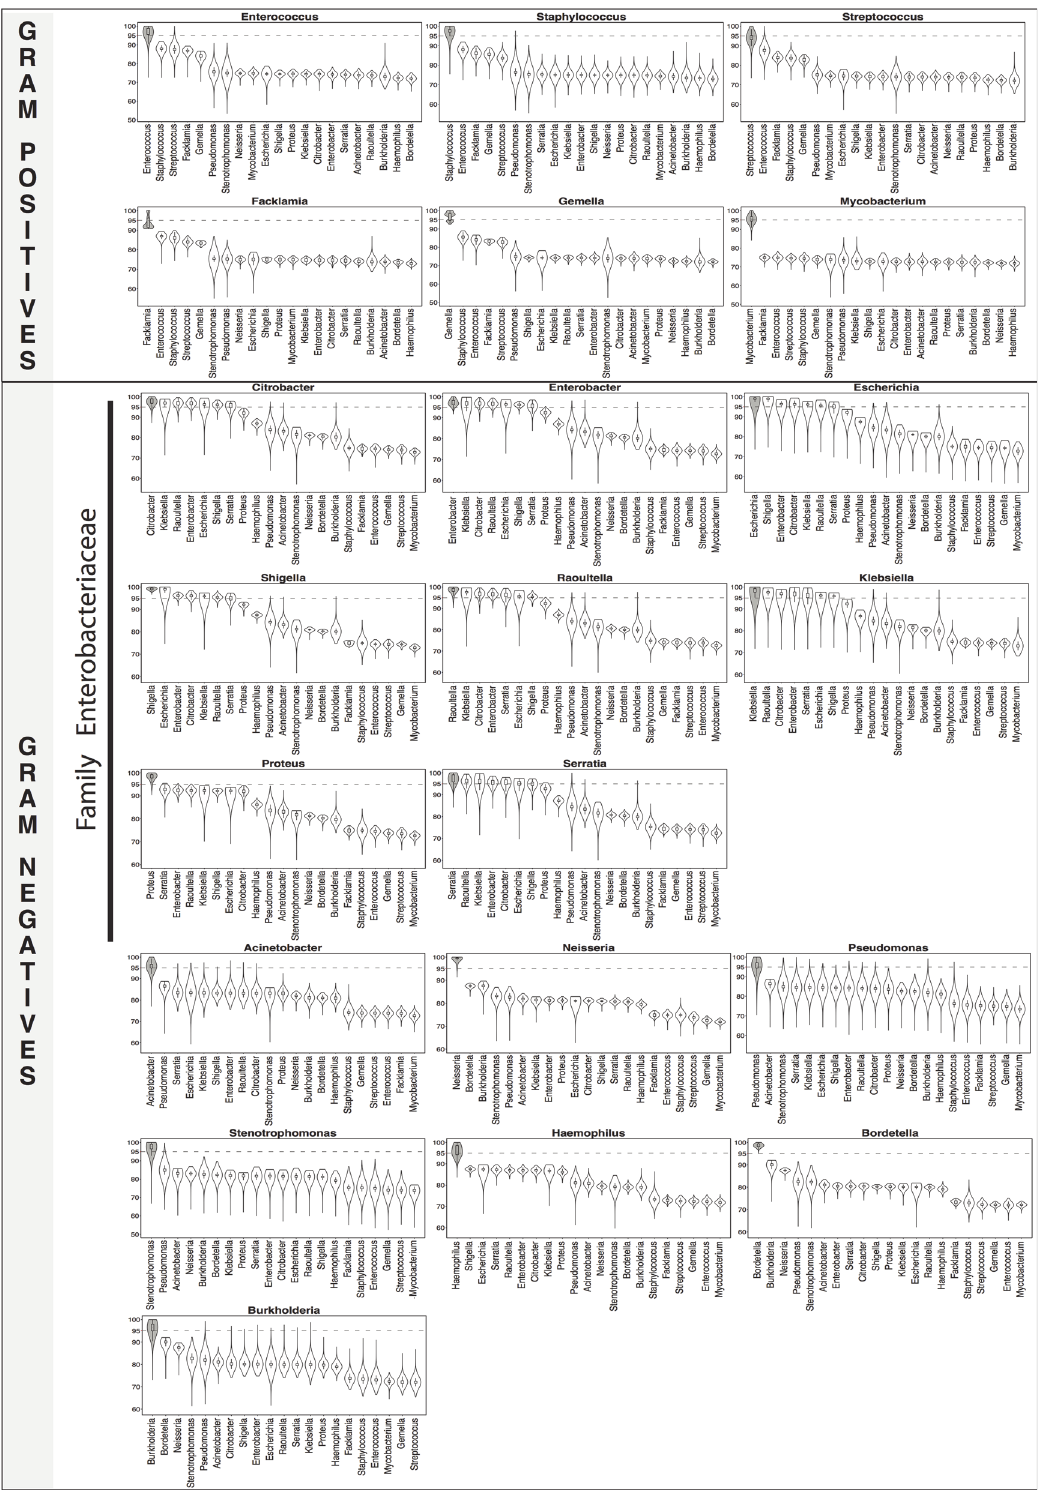
Fig 2. 16S rRNA percent identity within and between genera. Distributions (shown as violin plots) of 16S rRNA percent identity (y-axis of each figure) of pairs of training set sequences belonging to the same (gray) and different genera. 95% identity, the traditional genus level cutoff, has been marked for reference. The genus Mycobacterium has been categorized as a gram-positive in the figure. For all of the genera, sequence variability between sequences from the same genera was significantly higher than between those from different genera for all comparisons (Wilcoxon test one-sided p-value < 0.0001). doi:10.1371/journal.pone.0117617.g002 PLOS ONE | DOI:10.1371/journal.pone.0117617 February 6,